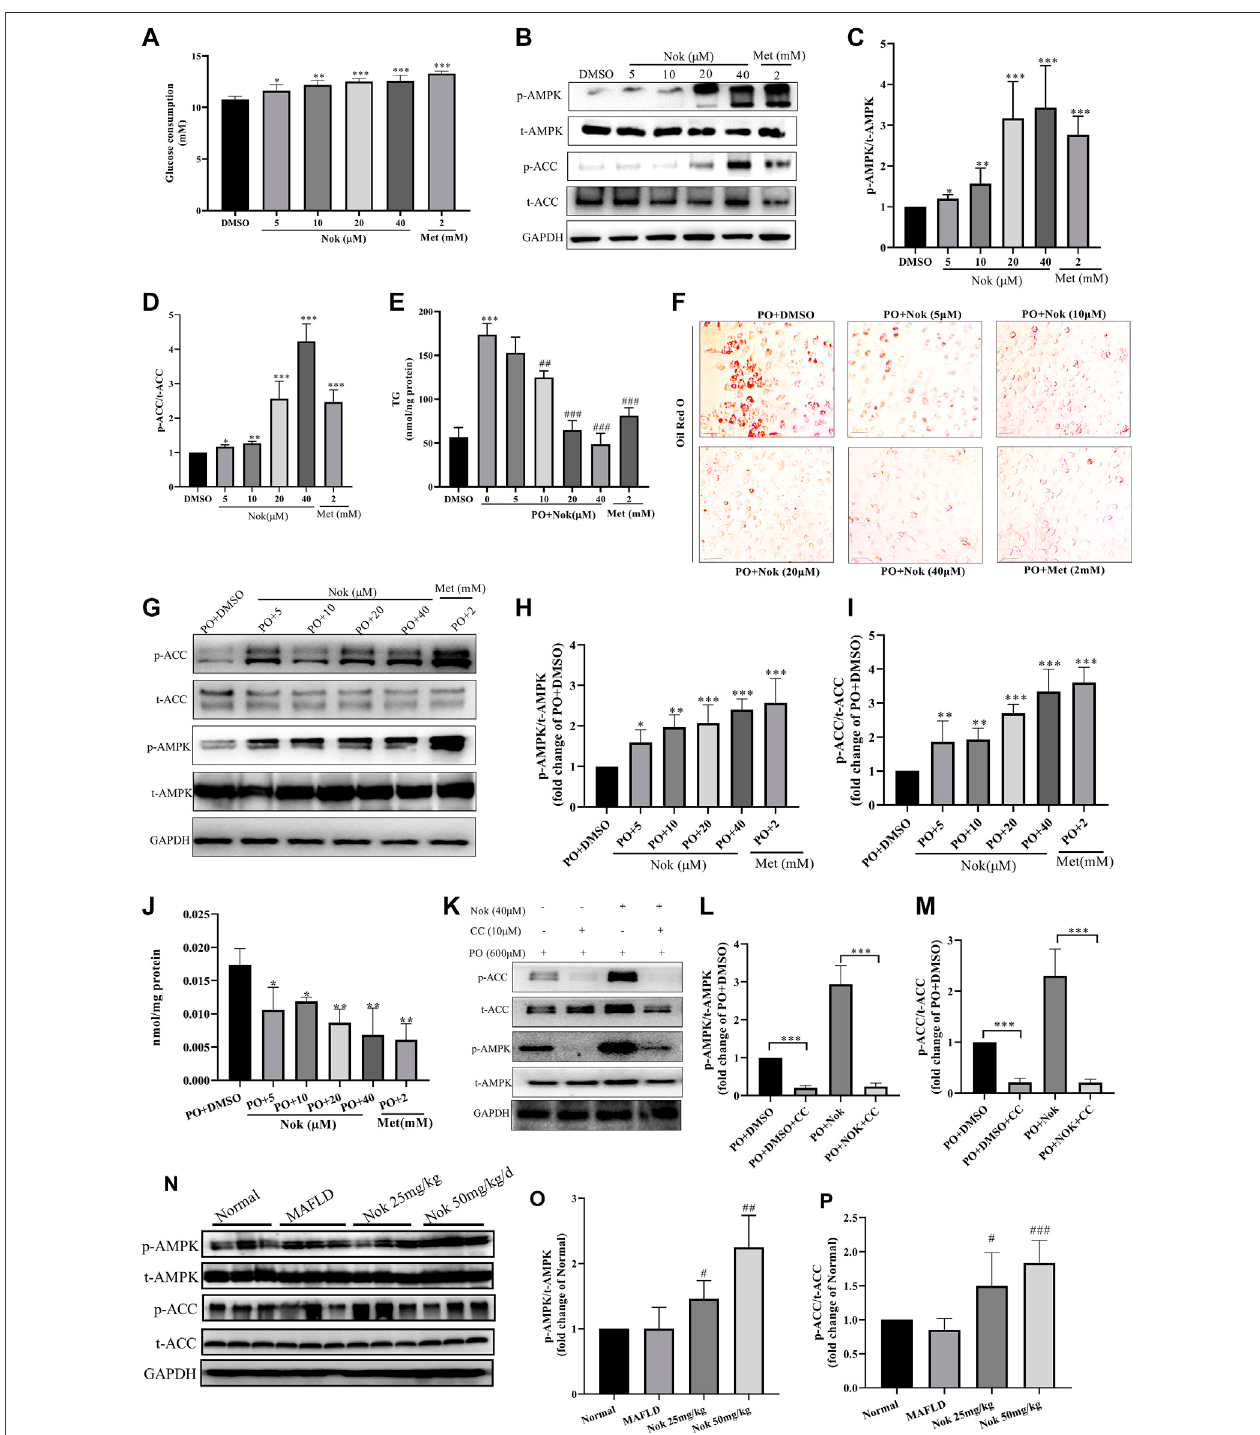
FIGURE5| Theeffects ofNokonglucoseand lipidmetabolism andAMPKactivation invitro and invivo . (A) Glucoseconsumption;valuesarethemeans±SD,n= 5, * p < 0.05,** p < 0.01or *** p < 0.001 vs.DMSO. (B) Western blotswere performed toanalyze thelevels ofp-AMPK, AMPK, p-ACC and ACC in L02cells. Examplesof representative blots as above and fold changes of p-AMPK/T-AMPK (C) and p-ACC/T-ACC (D) are shown by semiquantitative analyses. Values are the means ± SD from three separate experiments, * p < 0.05, ** p < 0.01, *** p < 0.001 vs. DMSO. (E) Intracellular TG detection in L02 cells treated with Nok and undergoing PO induction. Values are the means ± SD, n = 4, *** p < 0.001 vs. PO + DMSO, ## p < 0.01 or ### p < 0.001 vs. PO + DMSO. (O) Oil Red O staining detection in L02 cells treated with Nok and undergoing PO induction, and the representative image as above. (G) Western blots were performed to analyze the phosphorylated and